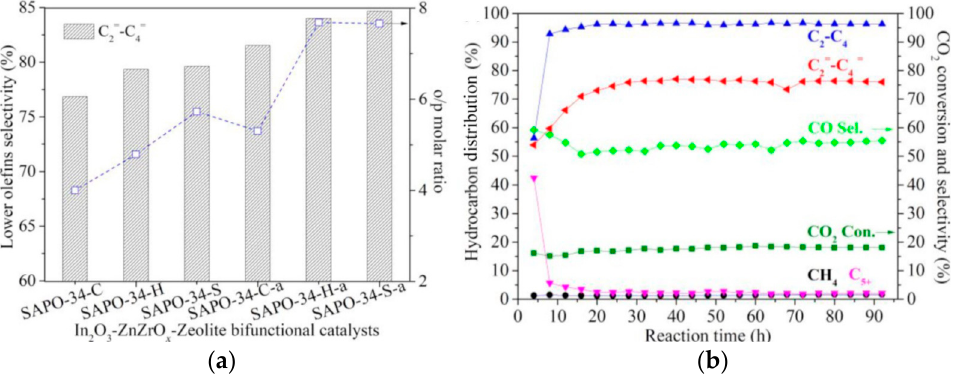
Figure 21. ( a ) Catalytic performance for CO 2 hydrogenation over a In 2 O 3 -ZnZrO x catalyst with different types of SAPO-34. ( b ) The stability of the bifunctional composite catalysts In 2 O 3 -ZnZrO x /SAPO-34-H-a (testing conditions: T = 653 K, P = 3.0 MPa, GHSV = 9000 mLg cat − 1 h − 1 , molar ratio of H 2 /CO 2 /N 2 = 73:24:3, mass ratio of oxide/zeolite = 0.5). Adapted with permission from ref. [42]. Copyright 2019 Wiley-VCH.